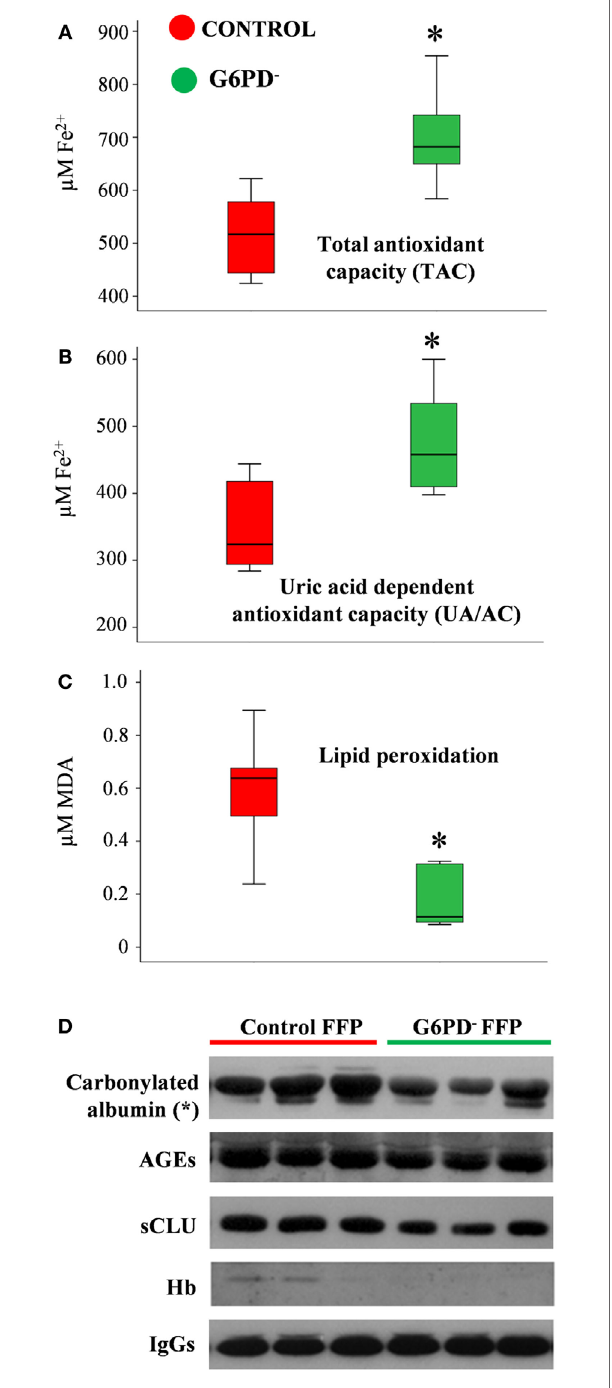
FigUre 1 | Redox status of fresh frozen plasma (FFP) units prepared from G6PD deficient (G6PD − ) and control donors. Levels of total antioxidant capacity (a) , uric-acid-dependent antioxidant capacity (B) , and lipid peroxidation (c) in FFP units from G6PD − donors ( n = 6) compared with control ( n = 6). MDA: malondialdehyde. (D) Representative immunoblots showing variation in the expression of stress protein markers in the two groups of FFP. AGEs: advanced glycation end-products. sCLU, soluble clusterin (apolipoprotein J). * p < 0.05, G6PD − vs. control FFPs.